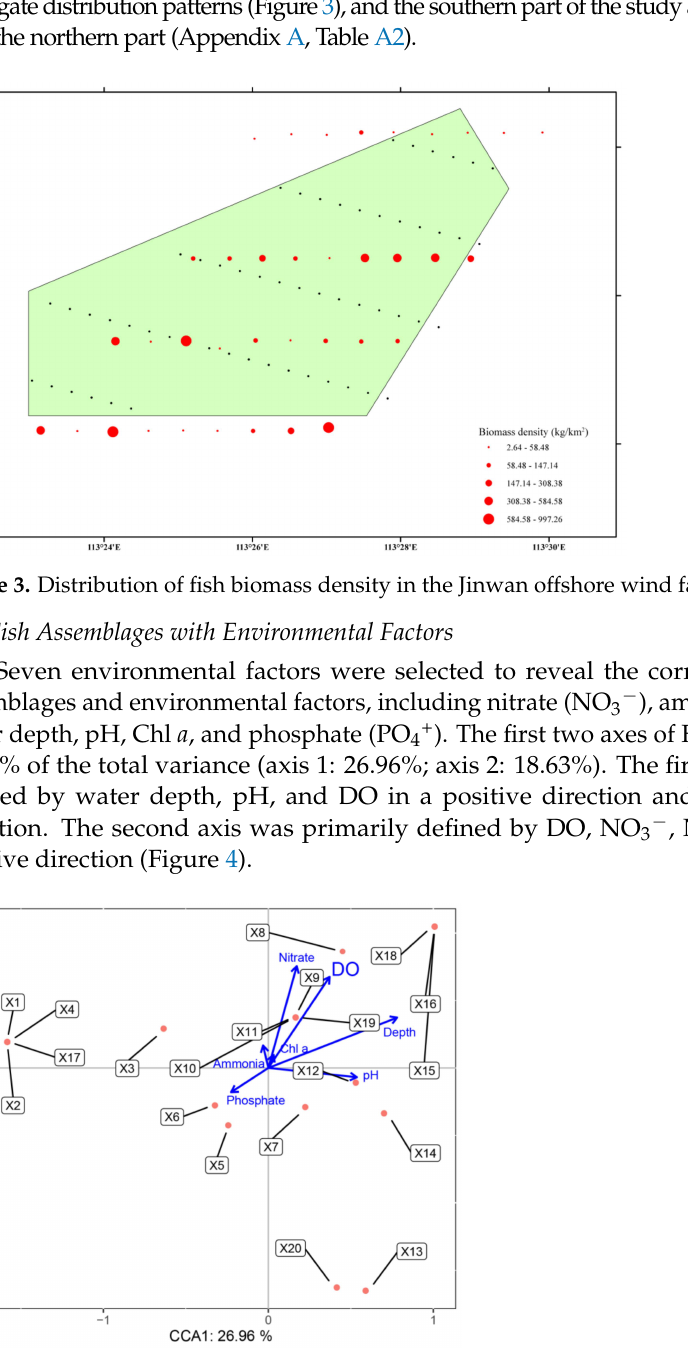
Figure 4. CCA analysis reveals the distribution of fish species in relation to environmental factors. X1: Plotosus lineatus , X2: Collichthys lucidus , X3: Siganus oramin , X4: Loligo duvaucelii Orbigny , X5: Polynemus sextarius , X6: Coilia mystus , X7: Harpadon nehereus , X8: Apogon ellioti , X9: Ophichthus evermanni , X10: Johnius belengerii , X11: Argyrosomus pawak , X12: Brionobutis koilomatodon , X13: Dysomma melanurum , X14: Apogon semilineatus , X15: Muraenesox cinereus , X16: Platycephalus indicus , X17: Trypauchen vagina , X18: Trichiurus lepturus , X19: Cynoglossus macrolepidotus , X20: Odontamblyopus rubicundus